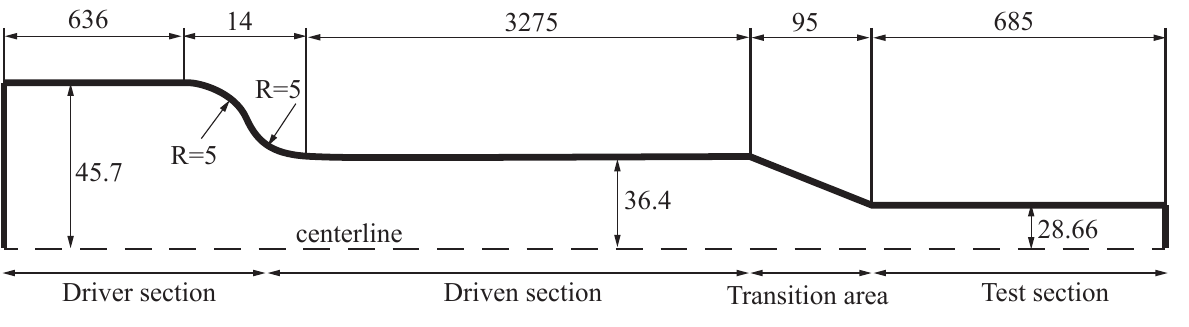
Figure 2. Schematic of the axisymmetric shock tube used in the simulation. Dimensions in mm; not to